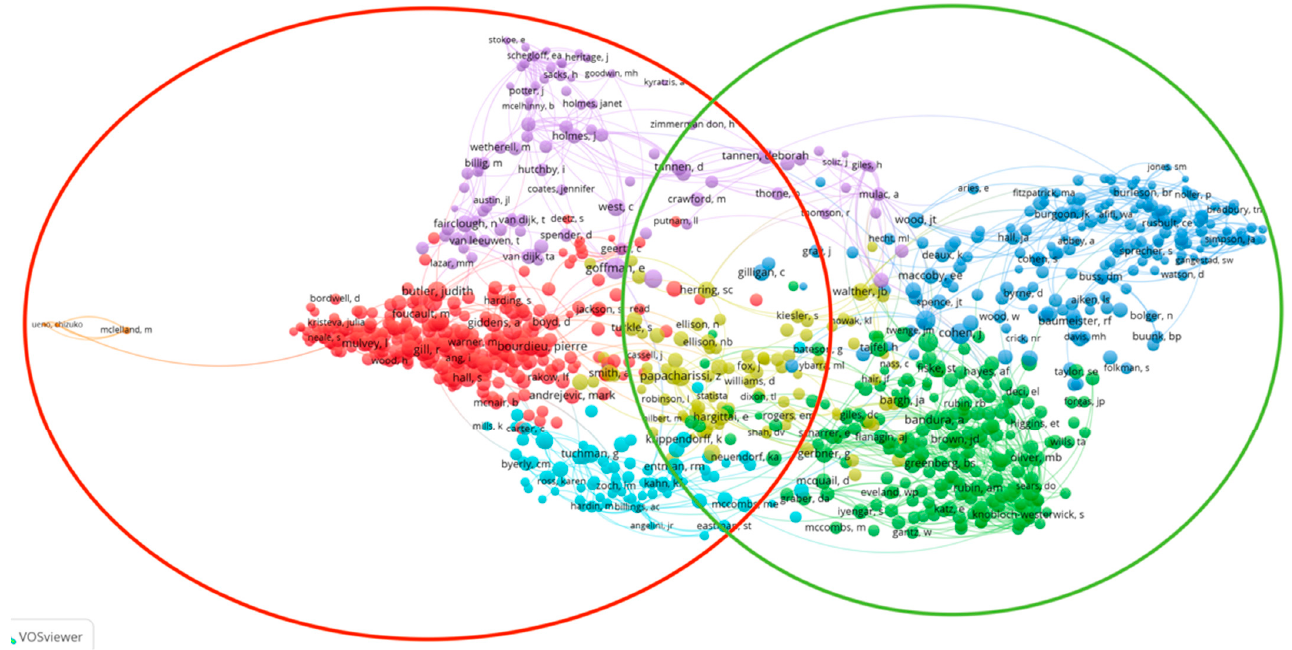
Figure 5. A combined visualization of the author map (Figure 2) and the keyword map (Figure